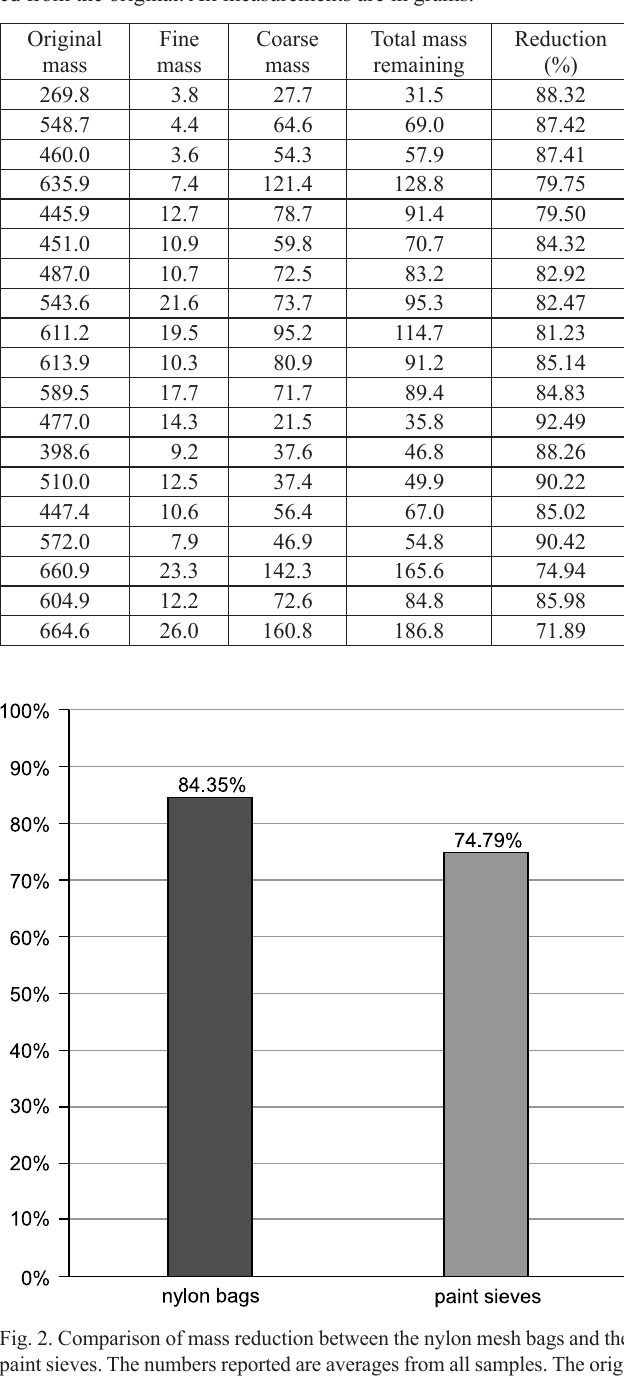
Table 2. Results from screenwashing using nylon mesh bags. Matrix was collected from the Two Sisters 2 Quarry located in the lower part of the Morrison Formation, Upper Jurassic, in northern Wyoming, USA. This method produces two size fractions of washed concentrate. End masses (Fine and Coarse fractions) were added together, then subtract- ed from the original. All measurements are in grams.